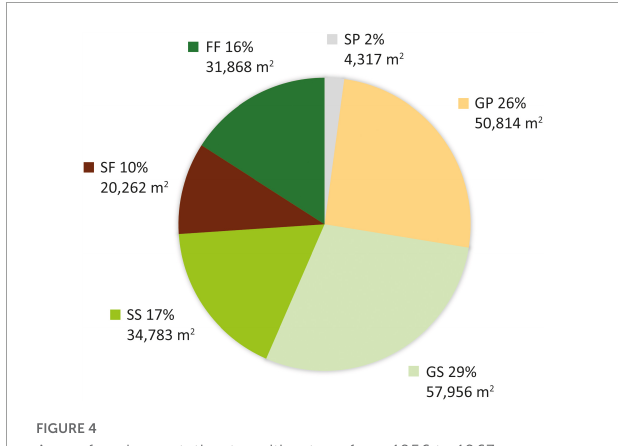
FIGURE4 Area of each vegetation transition type from 1956 to 1963.